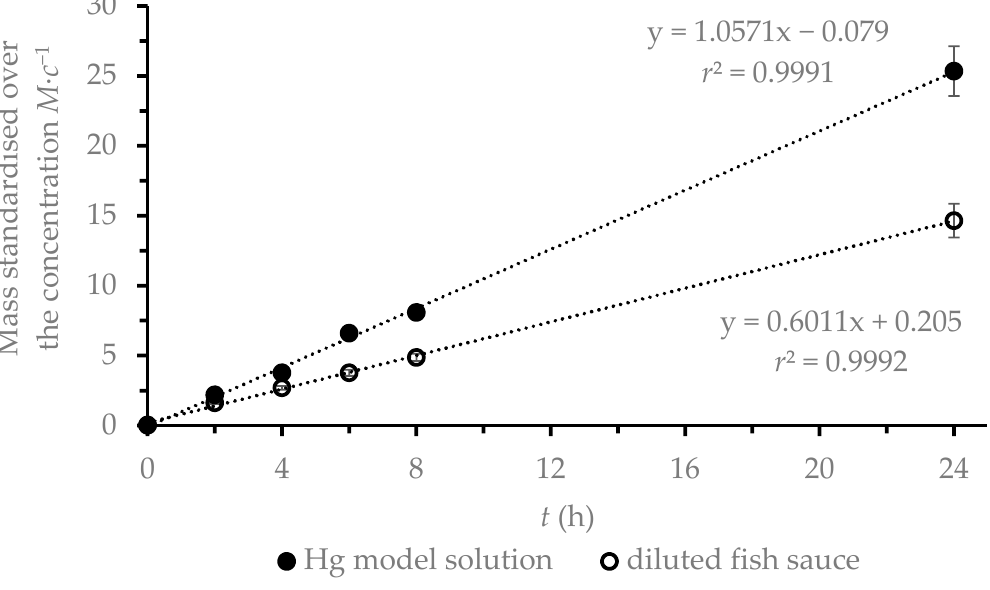
Figure 1. Measured mass of mercury in the binding gels immersed in Hg model solution and in diluted fish sauce over time.